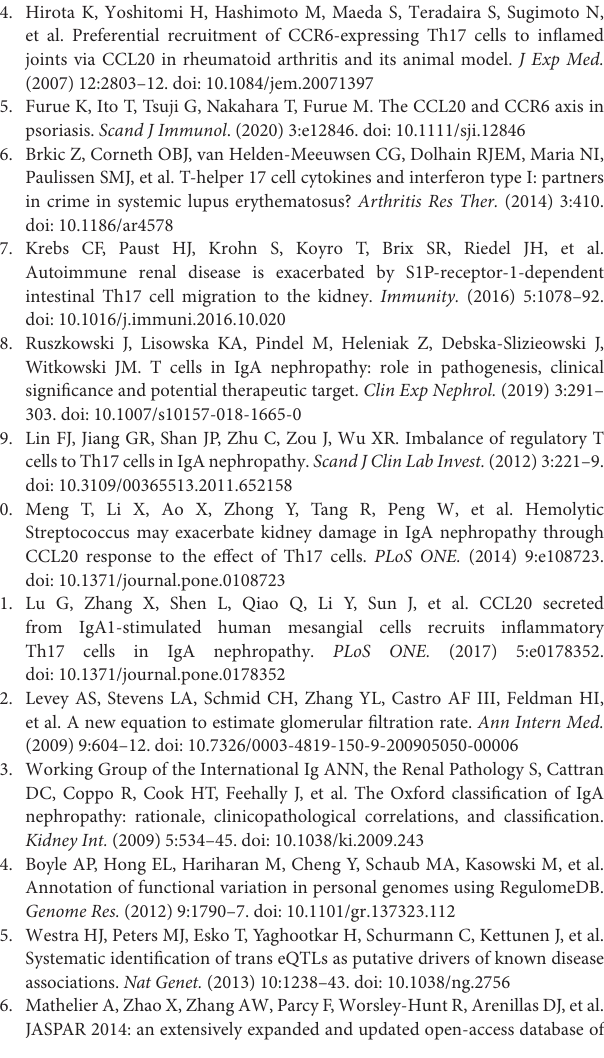
Supplementary Figure 2 | Flow cytometry gating strategy for CCR6 + cells. Supplementary Figure 3 | Genetic association of CCR6 common variants and IgAN. IgAN, immunoglobulin A nephropathy. Supplementary Figure 4 | Genetic association of CCR6 rare variants and IgAN. Supplementary Table 1 | Details of genotyping, quality control, and imputation for each cohort. Supplementary Table 2 | Associated regulatory variants after false discovery rate adjustment in cohort 1 and cohort 2. Supplementary Table 3 | Association of IgAN susceptibility and CCR6 rare variants in cohort 3. IgAN, immunoglobulin A nephropathy. Supplementary Table 4 | Functional annotations of 68 associated regulatory variants.